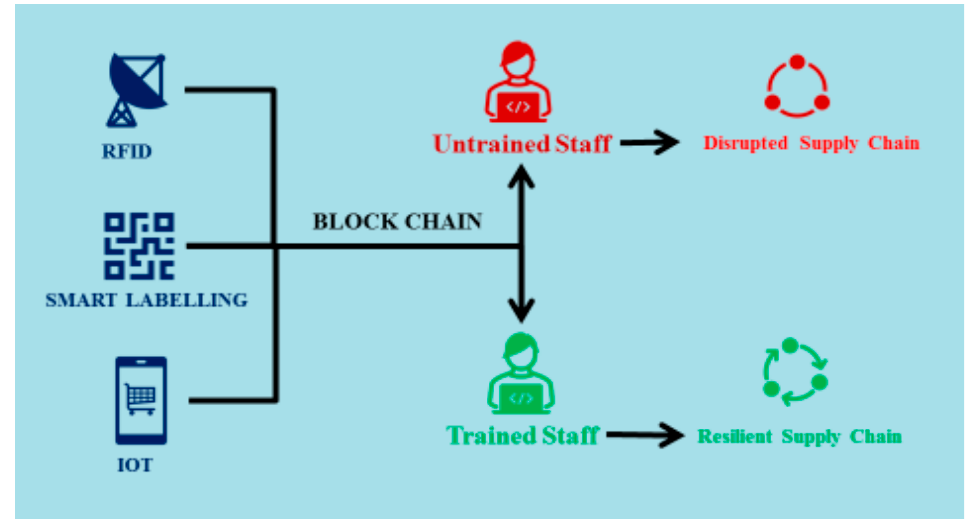
Figure 8. Correlation between implementing technologies and staff training.